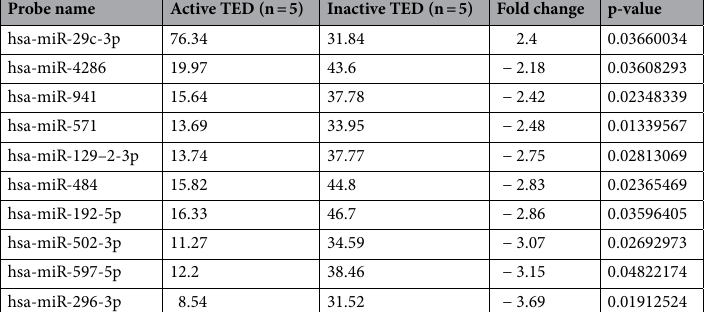
Table 3. Fold changes and associated p-values for 10 differentially expressed miRNAs between the active and inactive thyroid eye disease